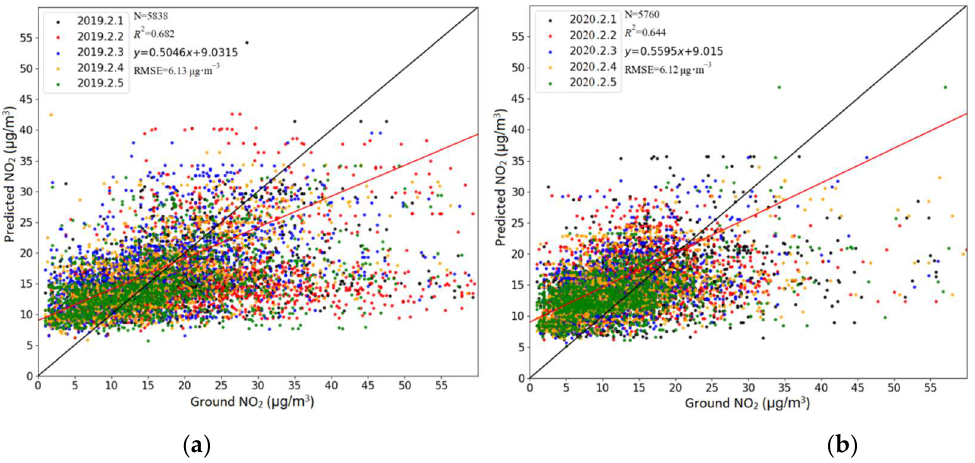
Figure 10. The correlation between predicted near-surface NO 2 concentration results by RF model